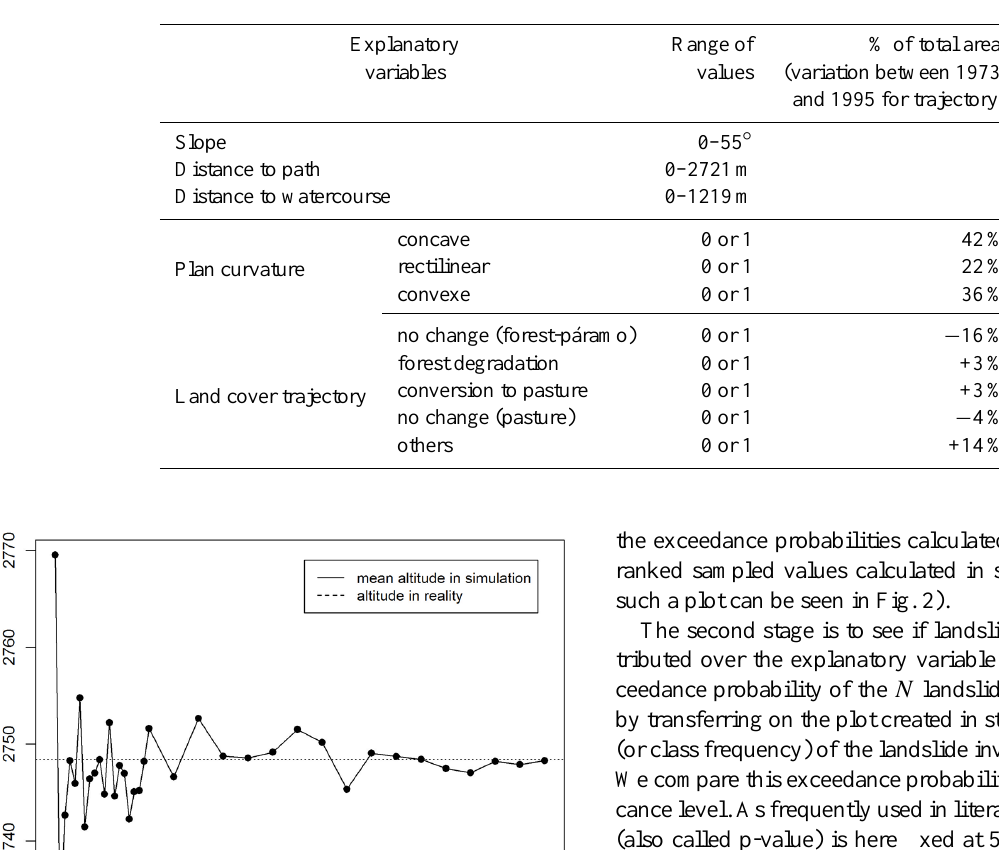
Table 1. Set of anthropogenic and biophysical variables included in the probabilistic and statistical analyses.